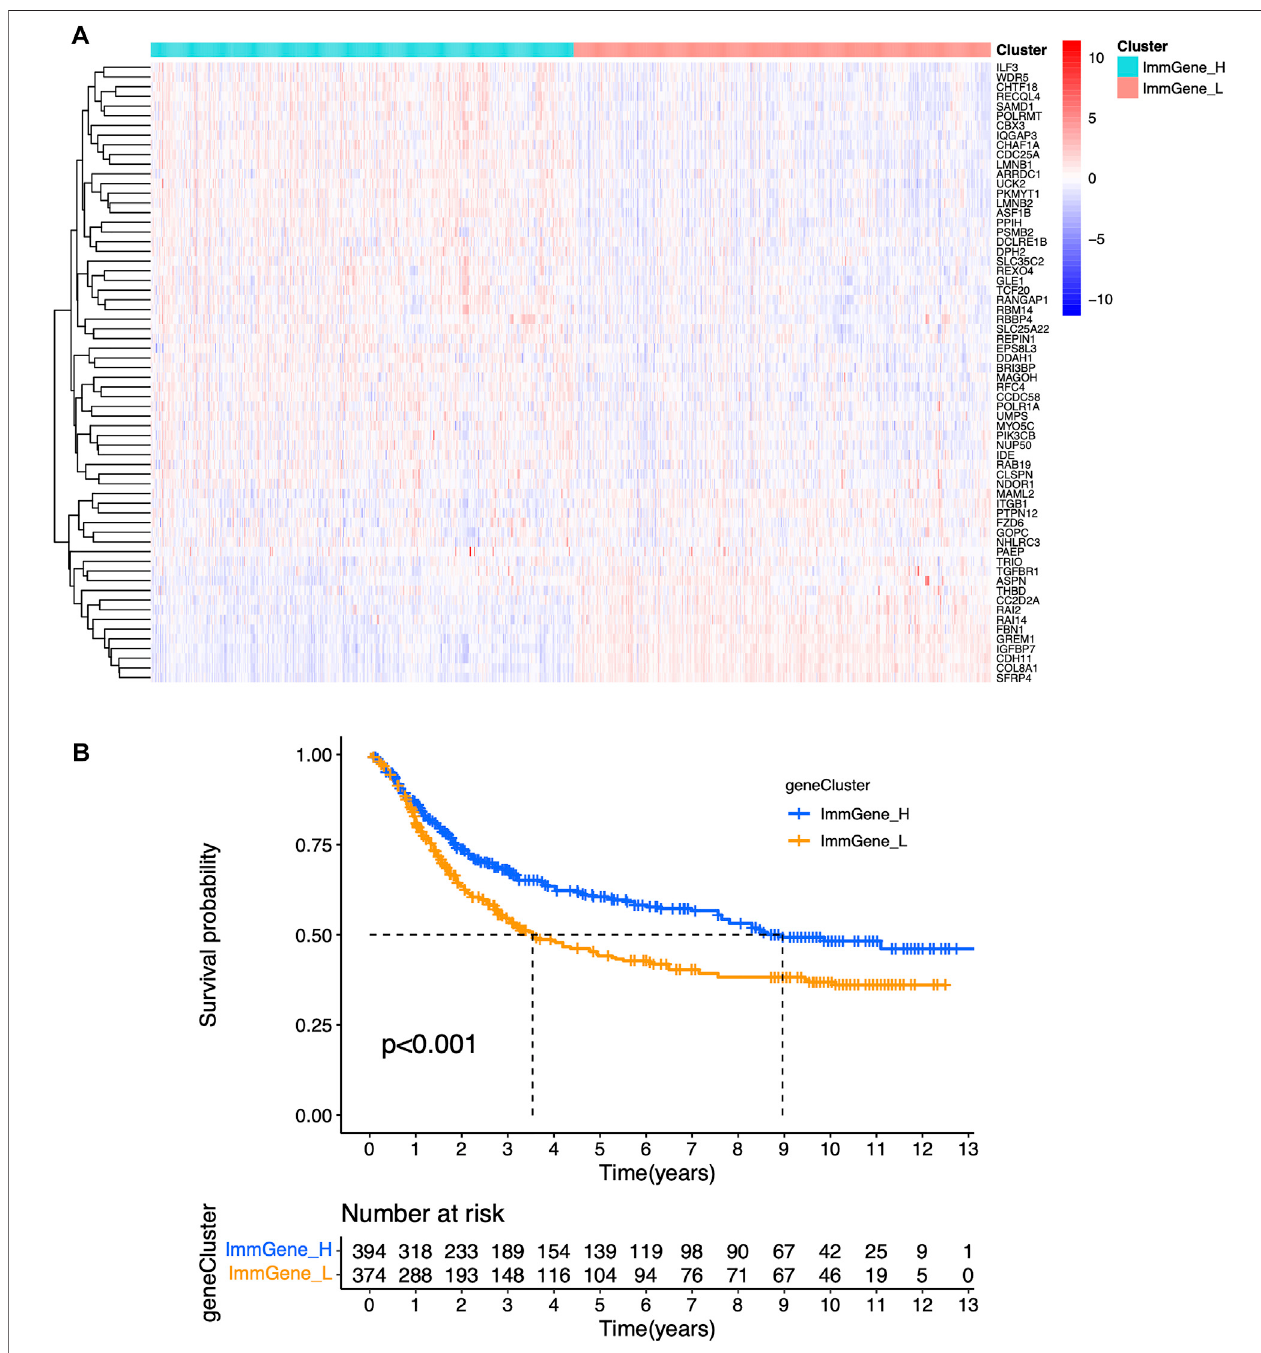
FIGURE 6 | Sample clustering based on m6A regulatory genes (A) Clustering heat map (B) Survival curve.